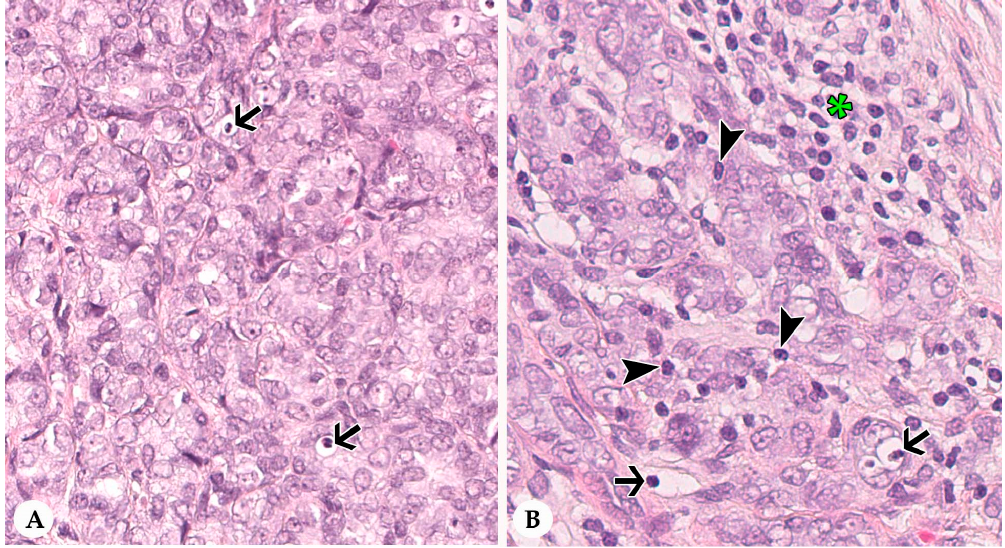
Figure 3. Intra-tumoral infiltrating lymphocytes (IT TILs) of pet rabbit mammary carcinomas. Depicted are two representative tumors with almost lack of IT TILs ( A ) and some IT TILs ( B ), respectively. In comparison to stromal TILs (asterisk), IT TILs (arrowheads) are immediately associated with tumor cells (arrowheads). Intra-tumoral cell fragments (arrows) are present ( A , B ). At the IM, average percentages of IT TILs differed between 0% and 10% (MV: 0.24%; SD: 1%). Most tumors (87%; 89/102) contained 0% average IT TILs, whereas 9% (9/102) and 3% (3/102) of carcinomas had an average of 1% and 2% IT TILs. In one tumor, 10% average IT TILs were detected. Maximal numbers of IT TILs at the IM per 20× objective FOV fluctuated between 0 and 40% (MV: 1%;